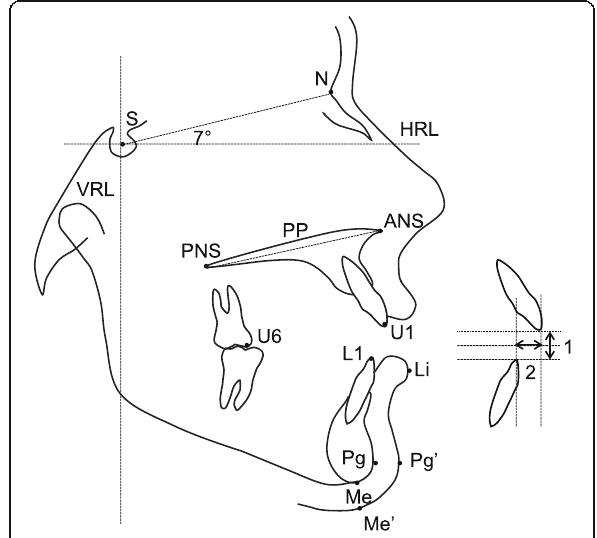
Fig. 1 Landmarks and reference planes. S, sella; N, nasion; ANS, anterior nasal spine; PNS, posterior nasal spine; U6, mesial cusp tip of maxillary first molar; U1, incisal edge of maxillary incisor; L1, incisal edge of mandibular incisor; Li, labrale inferius the most anterior point of lower lip; Pg, hard tissue pogonion; Pg ′ , soft tissue pogonion; Me, hard tissue menton; Me ′ , soft tissue menton; HRL, horizontal reference line; VRL, vertical reference line; PP, palatal plane; 1, overbite measured along VRL; 2, overjet measured along HRL